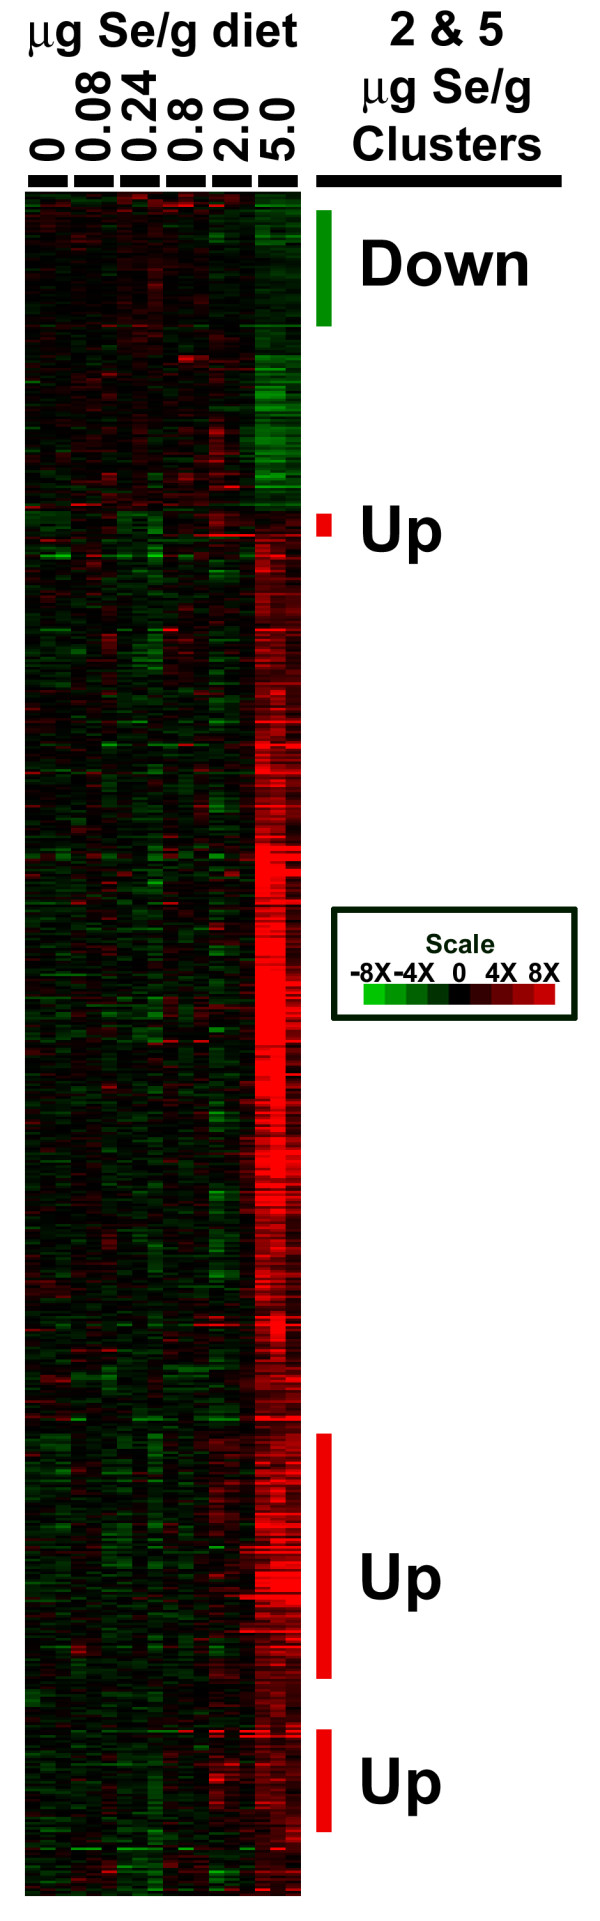
5 μg Se/g diet elicits a unique transcriptional effect. Unsupervised hierarchical clustering with RMA generated expression values for the 667 unique Se-specific transcripts (Figure 5). Columns represent liver expression from individual rats fed 0, 0.08, 0.24, 0.8, 2 and 5 μg Se/g diet. Rows represent probe sets. RMA gene expression is shown using the indicated pseudocolor scale from -8X (green) to +8X (red) relative to values for rats fed 0.24 μg Se/g. Clusters that are up-regulated by 2 and 5 μg Se/g diet are highlighted in red and the cluster down-regulated by 2 and 5 μg Se/g diet is highlighted in green.